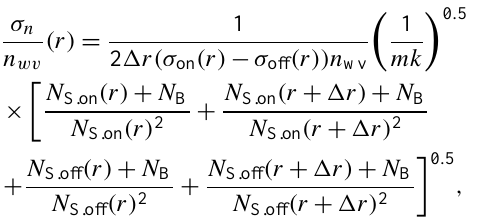
Fig. 5 (left panel) Fig. 5 (left panel). Data from Pike and Sabatier (2001). Wave- length scaled lower decile values from Table 4 on page 944. Water vapor concentration profile Fig. 5 (right panel). Data from Wulfmeyer and Walther